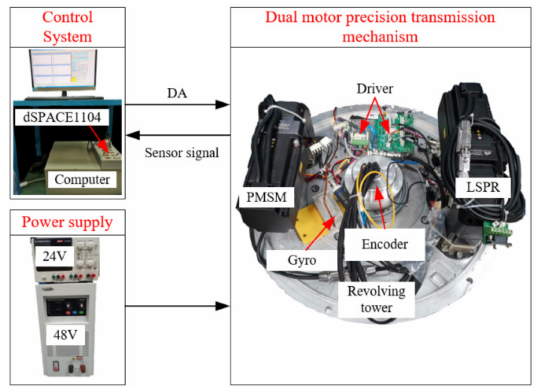
Figure 14. Experimental device for testing the